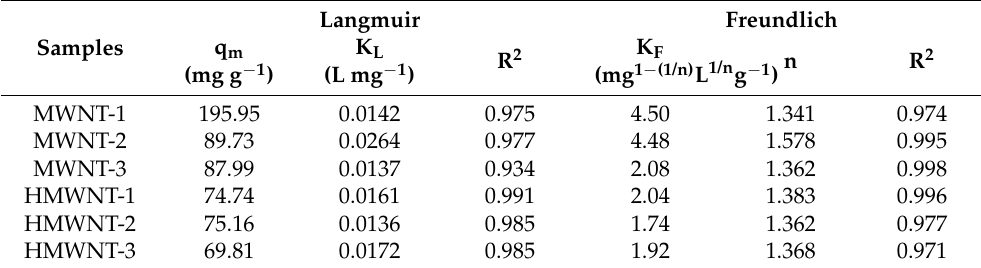
Table 2. Langmuir and Freundlich adsorption isotherm constant of HA on MWNTs and HMWNTs. Langmuir Samples